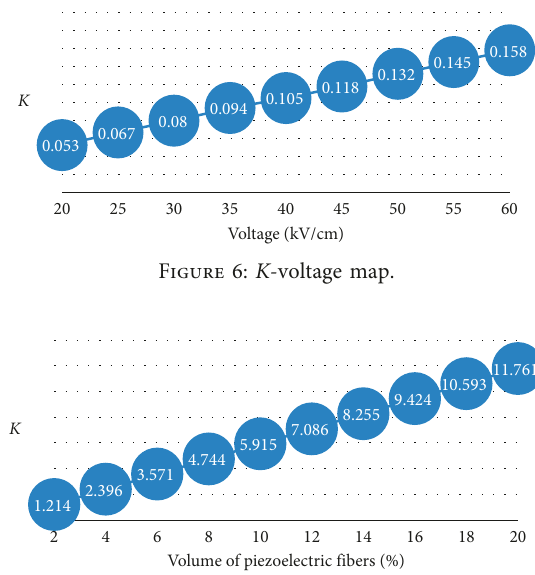
8: Frequency-response curves in the x direction with the electric field.